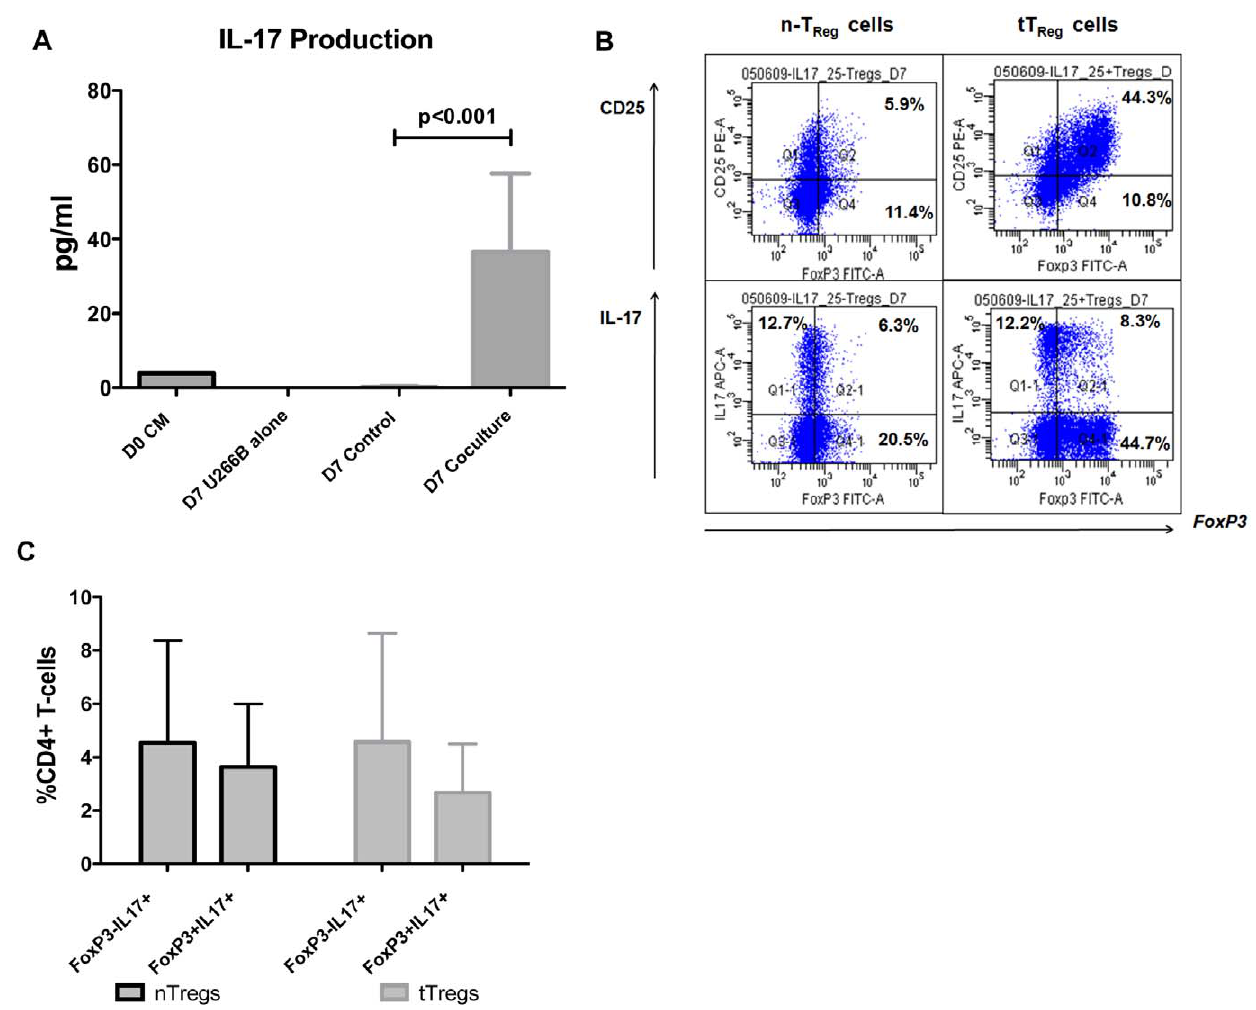
Figure 4. Natural and tumour-induced regulatory T-cell plasticity. A. The generation of IL-17 in co-culture supernatants of CD25 - CD4 + sorted T-cells with HMCL, compared with HMCl alone and culture medium (n=3). Results represent all experiments, expressed as mean 6 SEM. B. Representative dot-plots of IL-17 producing cells generated from re-stimulation of sorted tumour-generated and naturally occurring T Reg cells after 5 days of re-stimulation. C. The proportion of IL-17 producing cells generated from re-stimulation of sorted tumour-generated and naturally occurring T Reg cells, expressing FoxP3 after 5 days of re-stimulation, expressed as a percentage of CD4 + T-cells. Results expressed as mean 6 SEM.